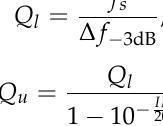
calculating the 3 dB bandwidth by Equation (9), and the unloaded quality factor ( Q u ) can be obtained according to Equation (10). We can see from the S 21 curve obtained from the simulation that after the SCC-PnC array is integrated into the resonator, the equivalent density of the resonator changes, which will cause the resonant frequency to change. Still, the change is minimal, and the change of the resonant frequency can be controlled by adjusting the structure size. The above analysis and calculation show how the specific performance parameters of the traditional resonator and the SCC-PnC resonator under different overtones can be compared. The specific performance parameters are shown in Table 4.